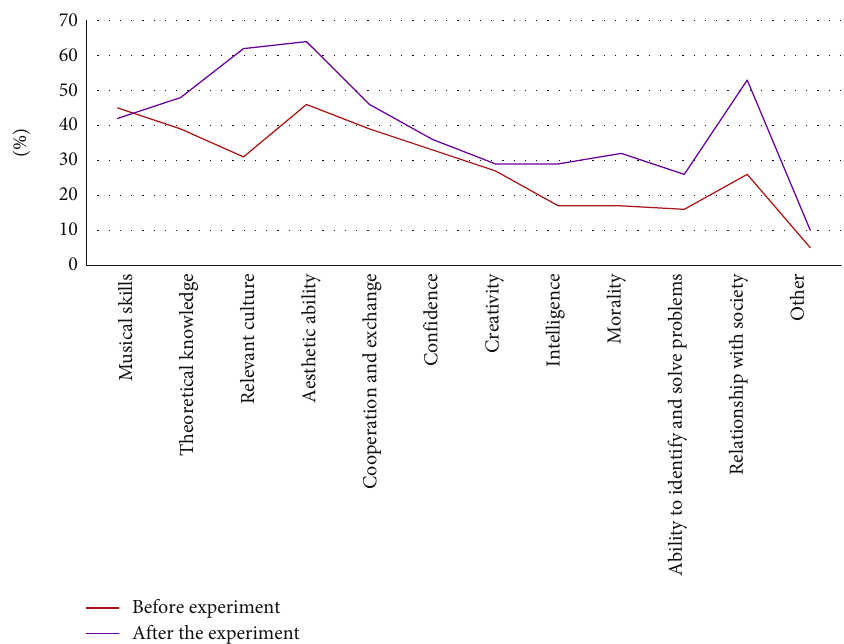
Figure 5: The proportion of students who chose the option of “ Summary of Learning Gains from Music Lessons ” .